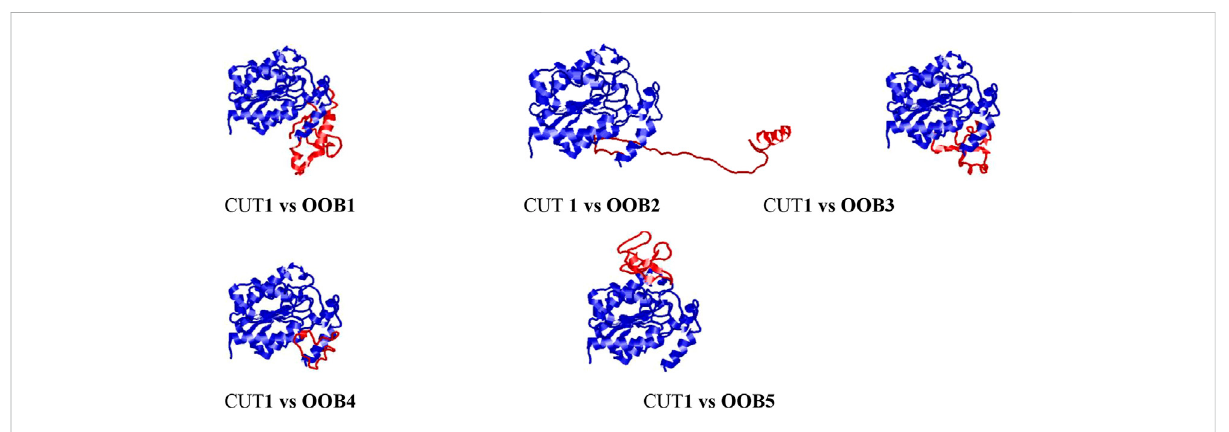
FIGURE 4 Docking interaction complexes between cut1 receptor protein (represented in blue) and anti- Fusarium solani AMPs (represented in red) visualized using